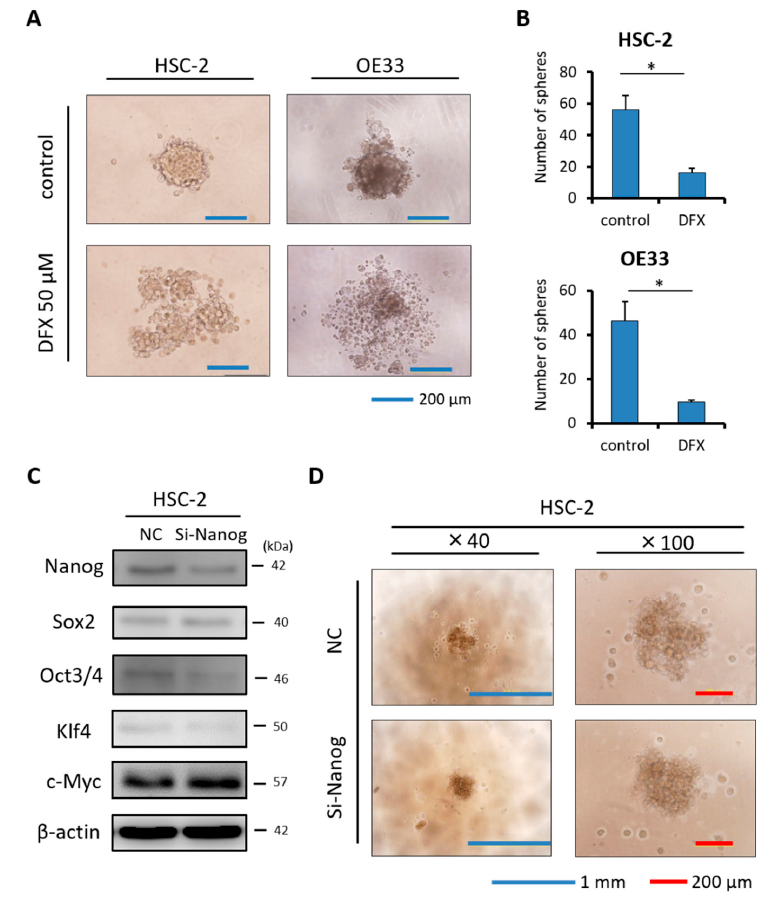
Figure 4. Effect of DFX on spherogenicity of human cancer cell lines and treatment with Nanog siRNA